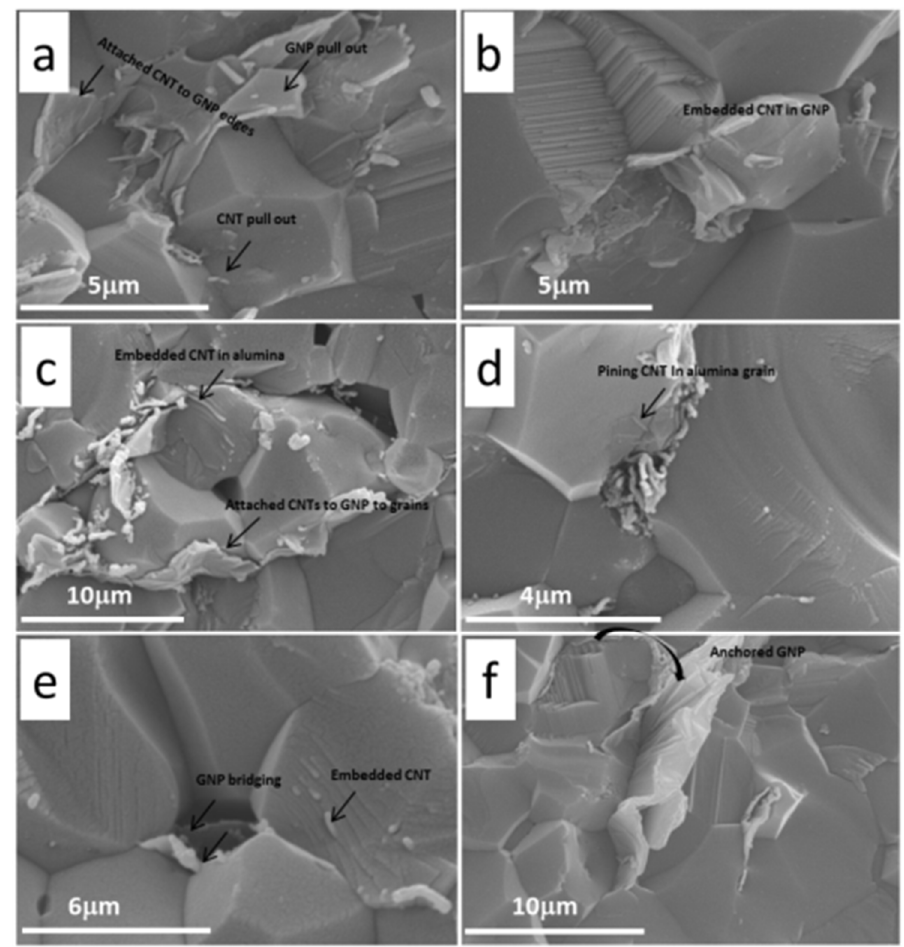
Figure 5. SEM images from fractured surface of GNT-Al 2 O 3 nanocomposites with various GNP/CNT ratio, ( a and b ); Al 2 O 3 -(0.5 wt% GNP + 1 wt% CNT), ( c–e ); Al 2 O 3 -(0.5 wt% GNP + 0.5 wt% CNT), ( f ); Al 2 O 3 -0.5 wt% GNP. Adapted from Reference [26]